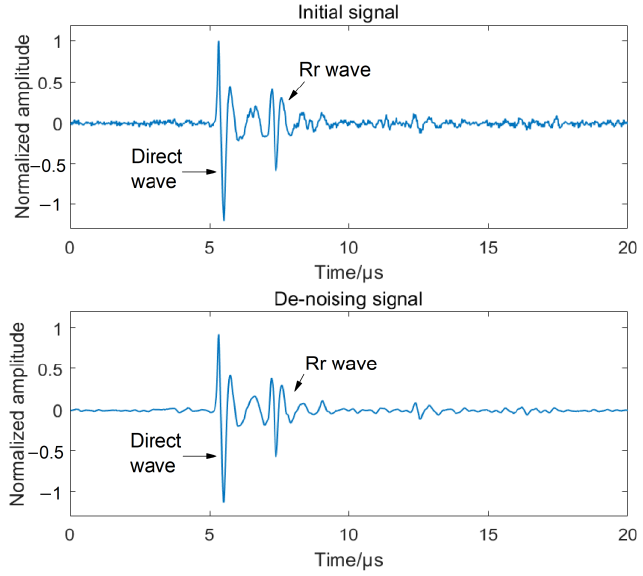
Figure 22. Initial signal and denoising signal of the Rr wave.